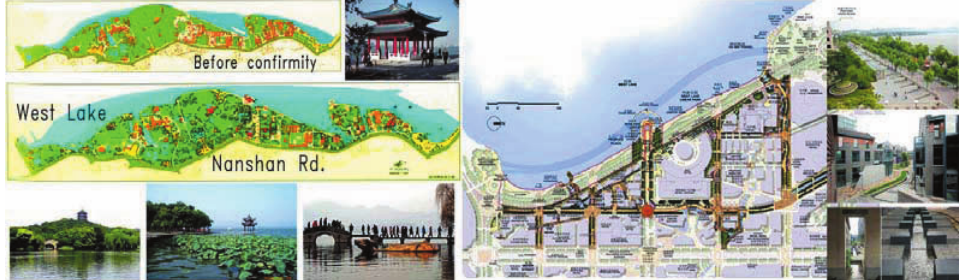
Fig.2 Landscape status of West Lake Waterfront and its master plan from Google Earth